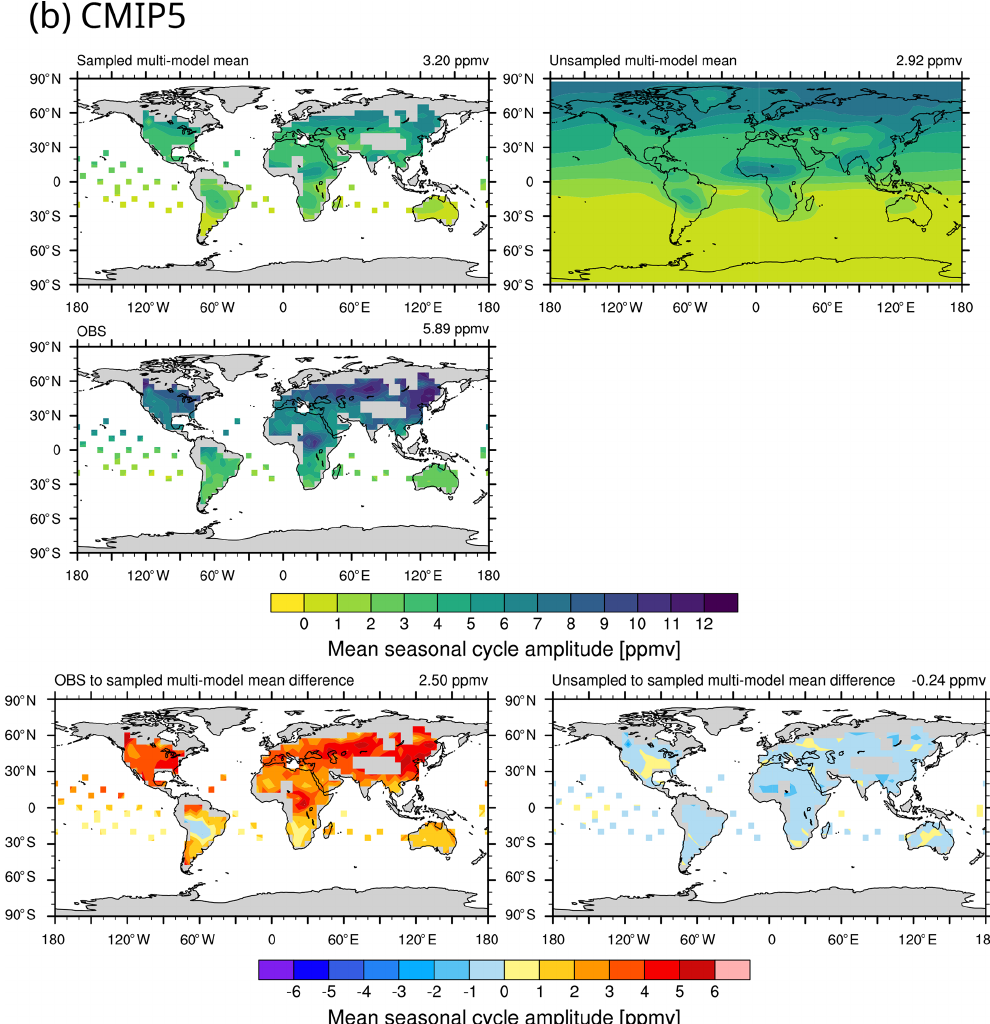
Figure 6. (b) Same as Fig. 6a but for the CMIP5 multi-model